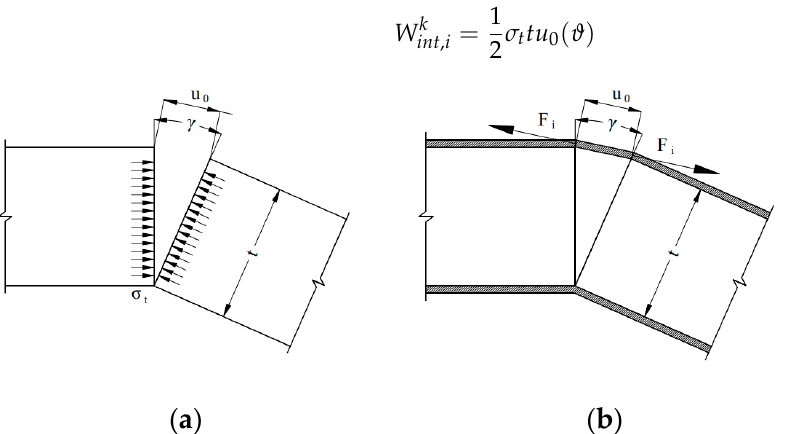
Figure 2. Stress distribution in an opening hinge: ( a ) perfectly plastic, and ( b ) hinge with perfectly plastic reinforcement.